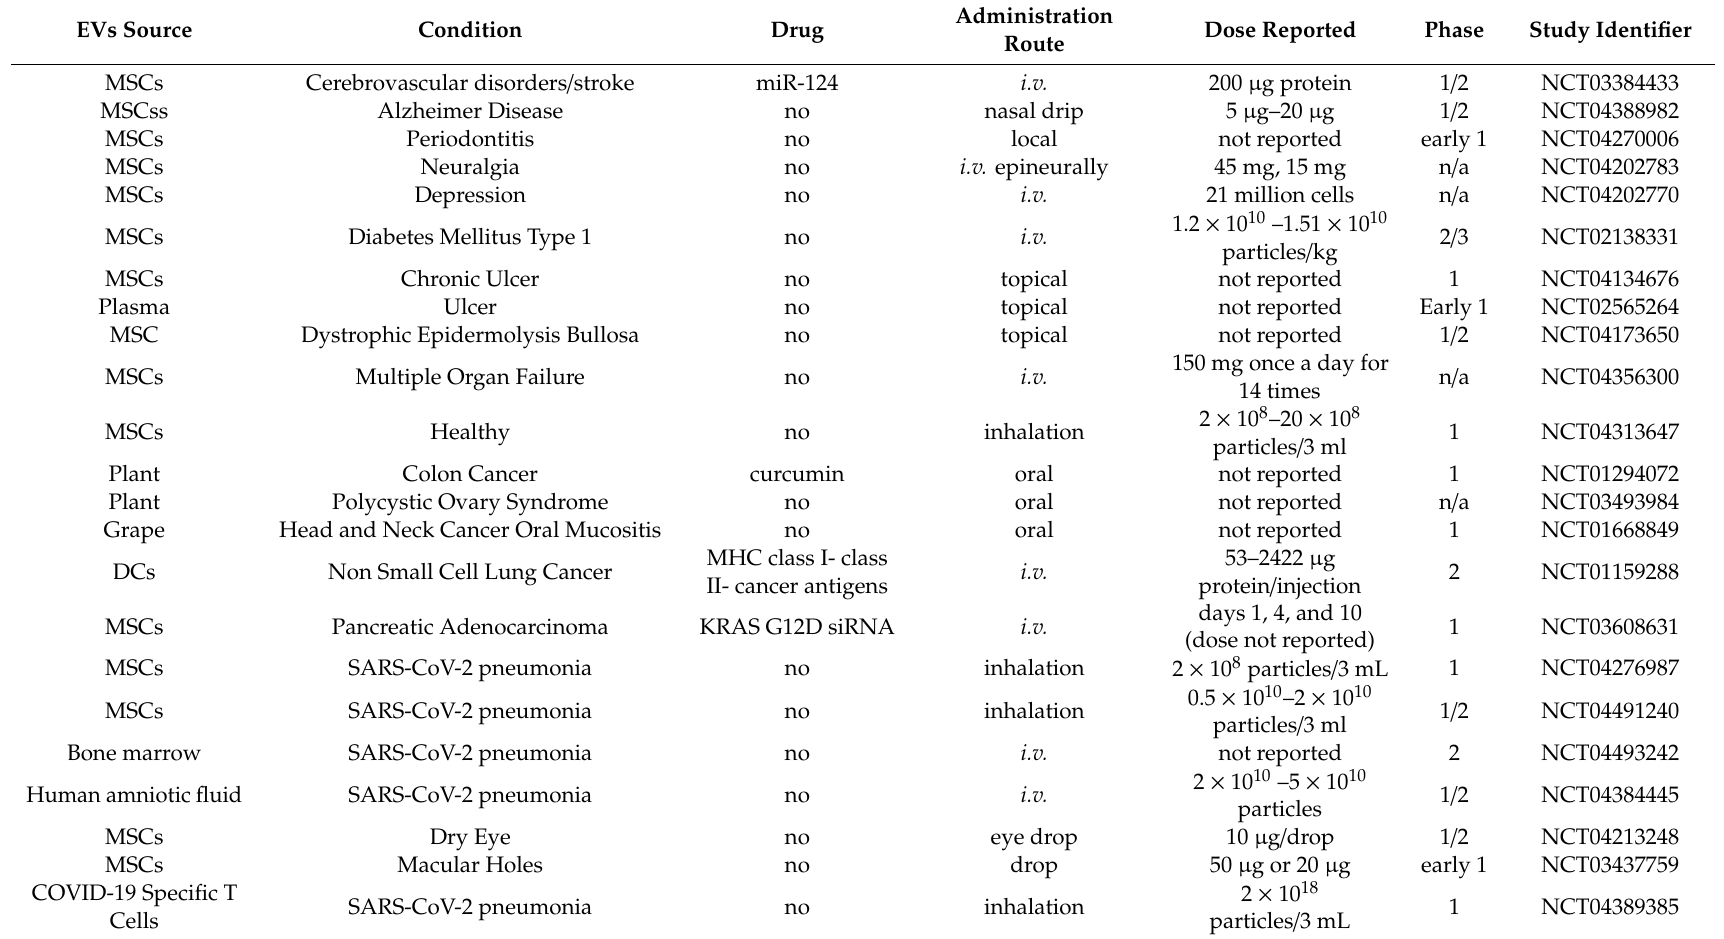
Table 3. Summary of clinical trials with EVs as an intervention (source: